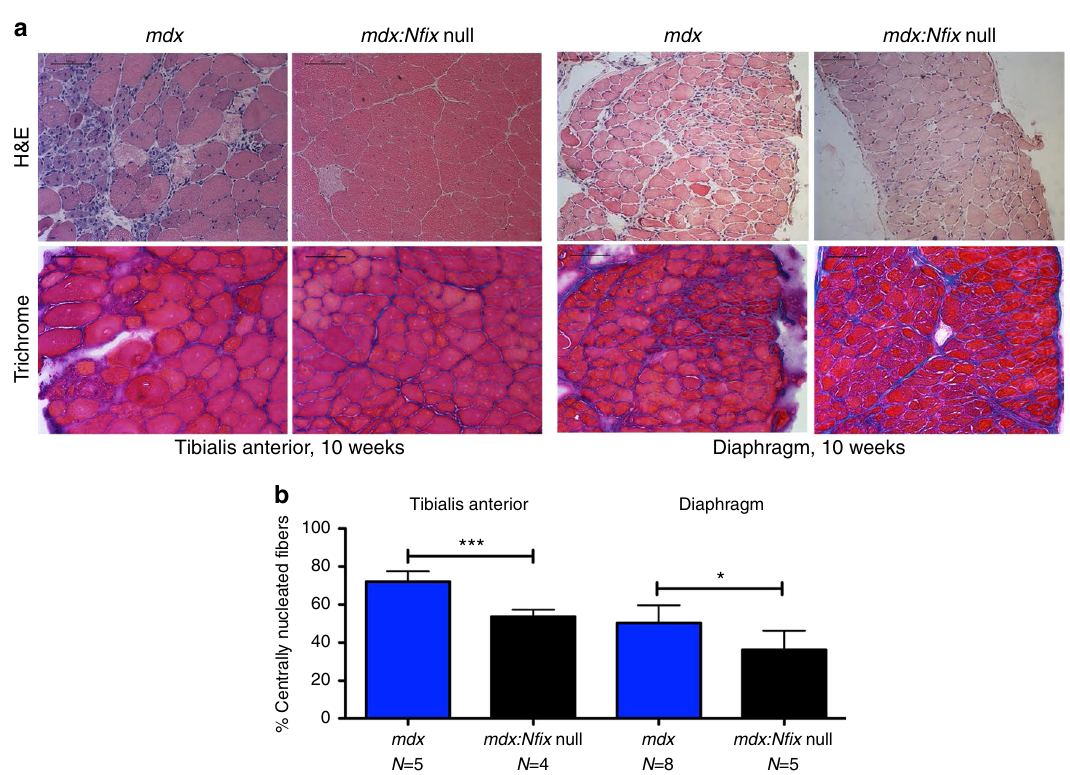
Fig. 6 Targeting N fi x ameliorates muscular dystrophy also in mdx mice. a Hematoxylin and eosin (H&E) and Milligan ’ s trichrome staining of tibialis anterior (left) and diaphragm (right) muscles at 10 weeks of age; N = 5 mdx and 4 mdx:N fi x null mice. Scale bar 100 μ m. b Percentage of centrally nucleated myo fi bers in tibialis anterior (TA) and diaphragm muscles at 10 weeks of age; N = 5 mdx and 4 mdx:N fi x null mice for TA. N = 8 mdx and 5 mdx: N fi x null mice for diaphragm. Mean ± SD, t test, * P < 0.05; *** P < 0.001. See also Supplementary Fig. 3 for the analysis of utrophin and myostatin levels